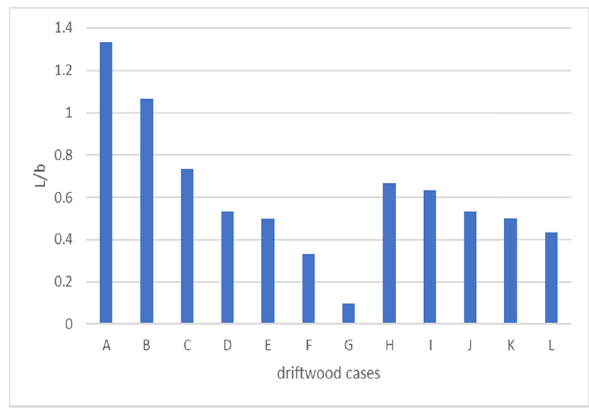
Figure 5: The relation of driftwood length to sluice gate width for all driftwood